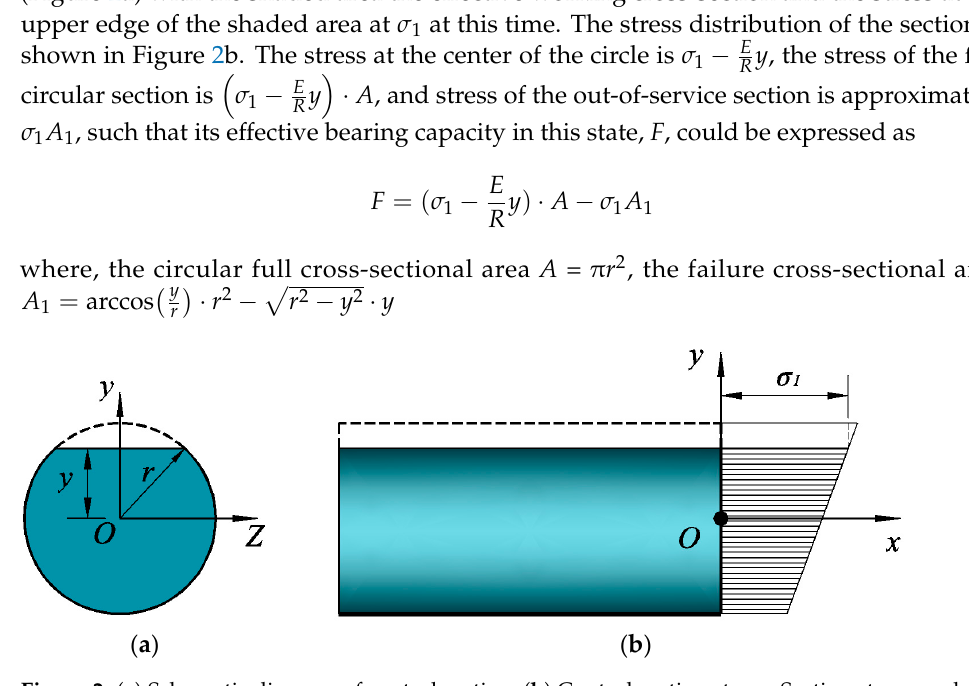
Figure 2. ( a ) Schematic diagram of control section, ( b ) Control section stress. Section stress analysis.